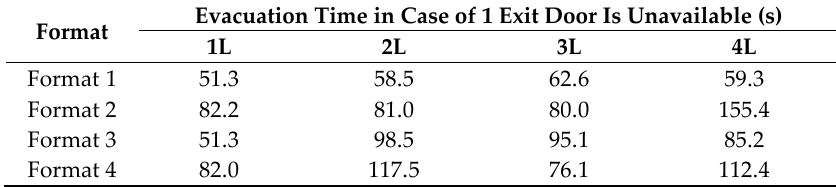
Table 5. Evacuation time in case of 1 exit door is